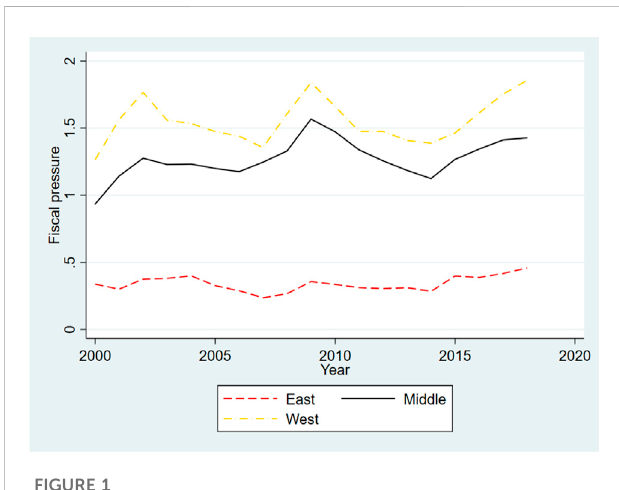
FIGURE 1 Financial pressure in eastern, central and Western